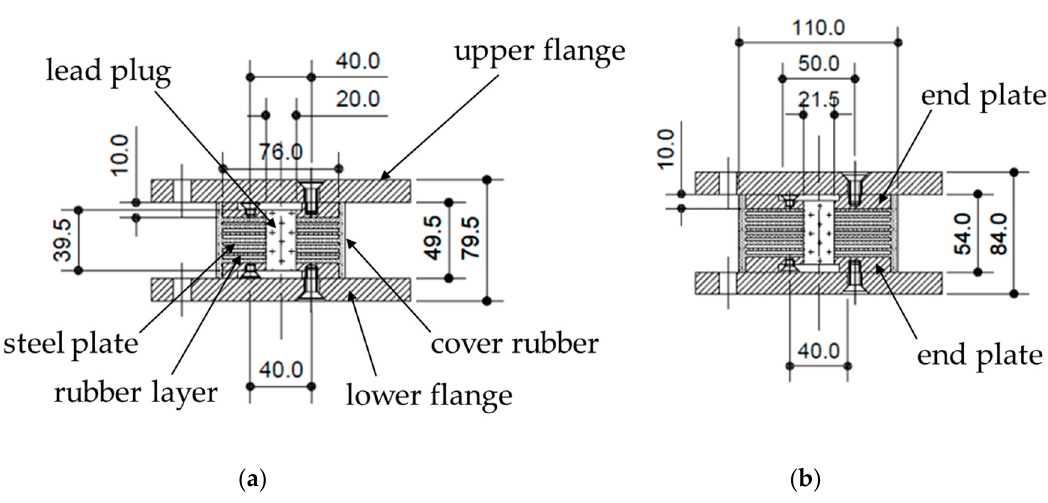
Figure 1. Dimensions and configurations of the proposed LRB: ( a ) OPT-1; ( b ) OPT-2.